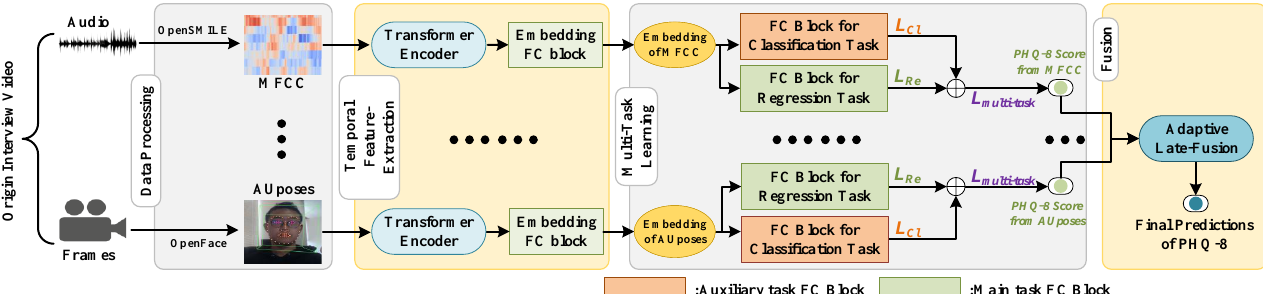
Figure 1. Overview of our proposed method. The origin data is firstly processed in the Data Processing Stage which has been done in the AVEC 2019 DDS dataset. Then the Transformer Encoder is used for extracting temporal information. The Embedding FC Block combined by a RELU activation layer, a dropout layer and a fully-connected layer is used to extract the hidden embeddings representing each kind of feature. The embeddings from each kind of feature are fed to two FC block s to perform multi-task predictions. Finally, the results from different features are fused in the Adaptive Late-Fusion to predict the final results. The L Re means the Concordance Correlation Coefficient Loss for PHQ-8 regression and the L Cl means the Cross Entropy Loss for 5-class